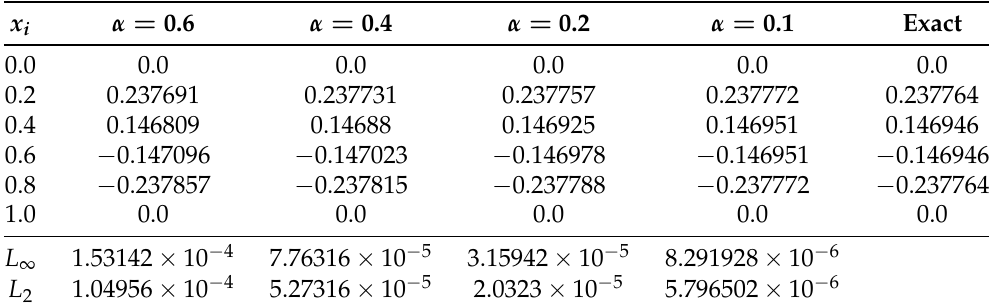
Table 6. Error norms, numerical solutions and comparison of the exact solution of real part of